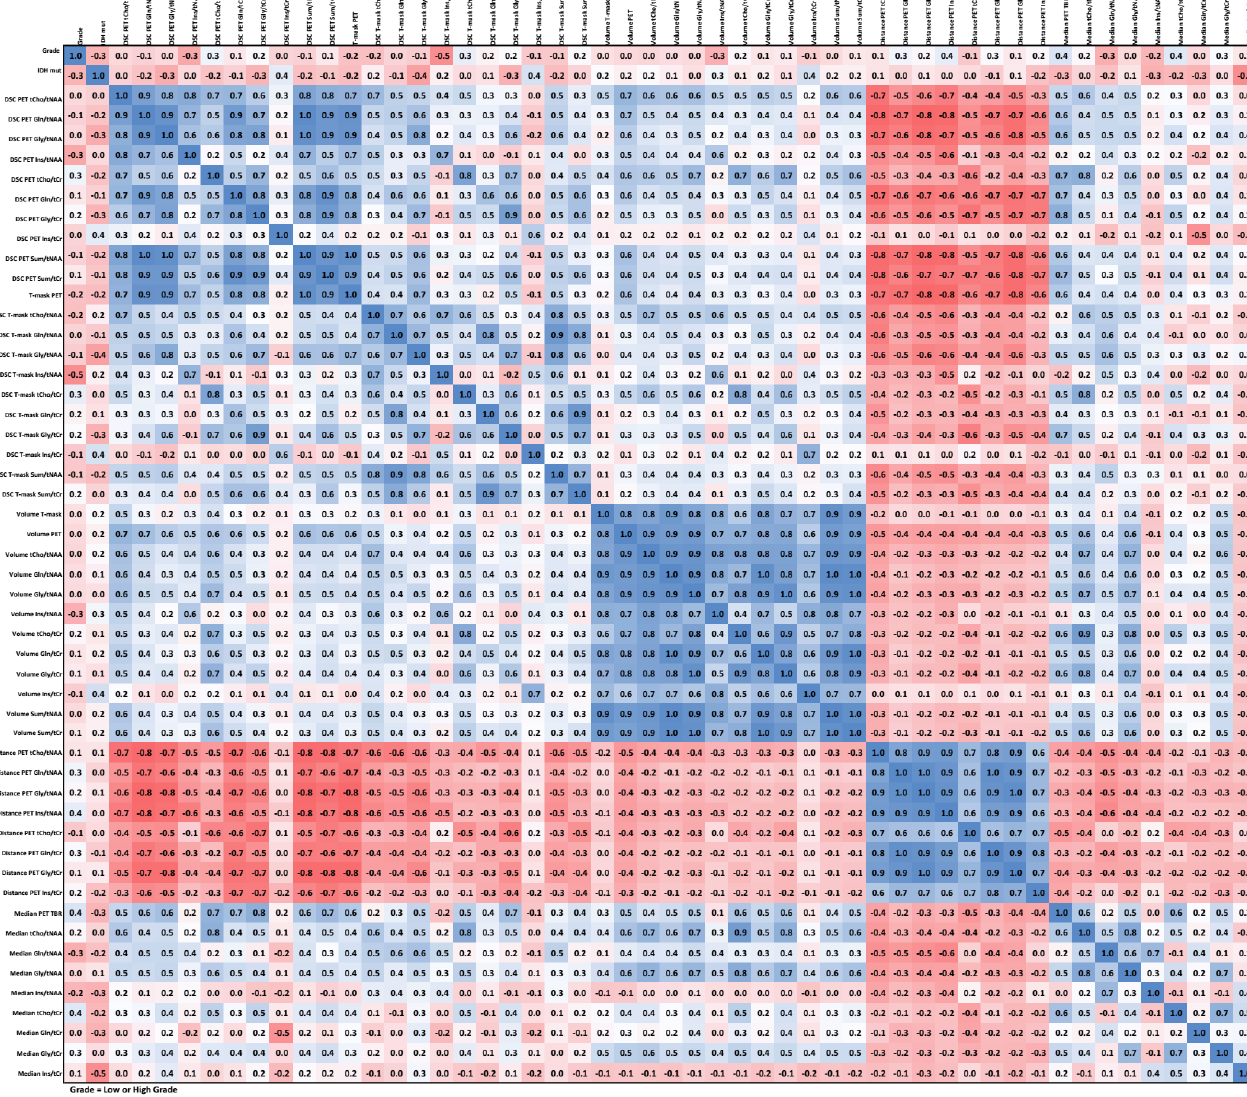
Figure 6. Correlation matrix for the TSEG1.6 VOI. An expected negative correlation between distance and the other parameters is the most visible feature. All correlation matrices are presented with higher readability in the supplementary data.